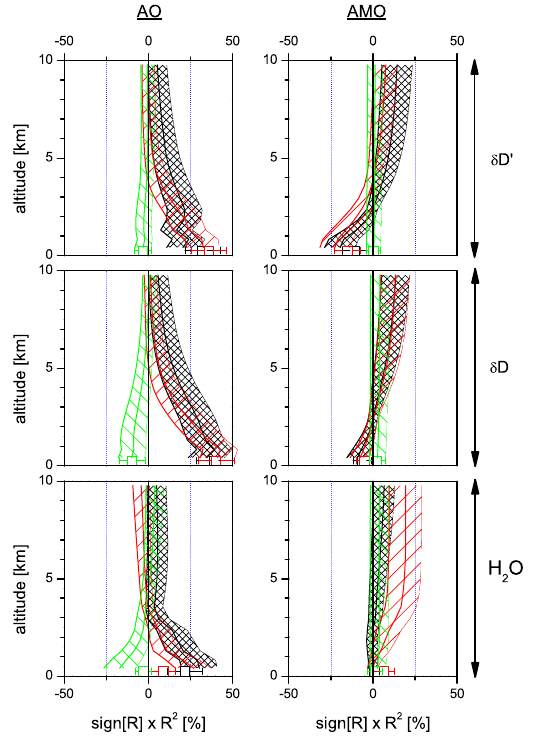
Fig. 13. Influence of the AO and the AMO index on Kiruna’s tro- posphere: vertical profiles of the coefficients of determination R 2 between quarterly mean FTIR and IsoGSM data, on the one hand, and the AO and AMO index, on the other hand. Left panels: corre- lation with AO index; right panels: correlations with AMO index; panels from bottom to top: correlations with H 2 O (H 2 O anomaly expressed as ln [ H 2 O ] ), with δ D, and with δ D 0 ( δ D and δ D 0 anomaly expressed as ln [ HDO ] [ ). Black line: FTIR data; red line: nudged run H 2 O ] IsoGSM data; green line: free run IsoGSM data. The hatched ar- eas represent the 1 σ significance intervals. The open squares and error bars upon the bottom x-axis represent R 2 and 1 σ significance interval for column integrated